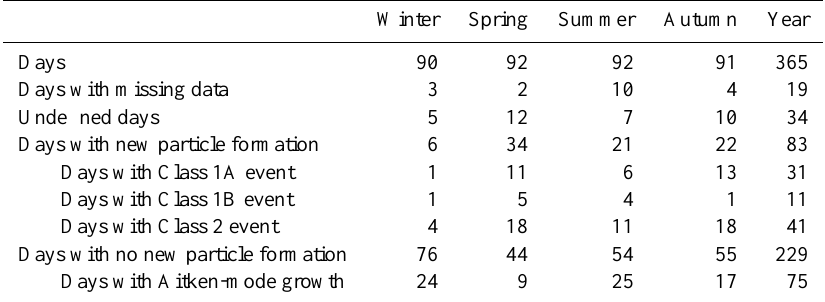
Table 1. Total number of days considered, number of days when measurement data were missing for more than 4h, days with undefined new particle formation feature, days with evident new particle formation event, and days obviously without new particle formation event for the four seasons and whole year near central Budapest from 3 November 2008 to 2 November 2009. Number of days for the major subclasses of new particle formation, i.e., Classes 1A, 1B and 2; and number of days with obviously no new particle formation but with substantial growth of the Aitken mode are also indicated.